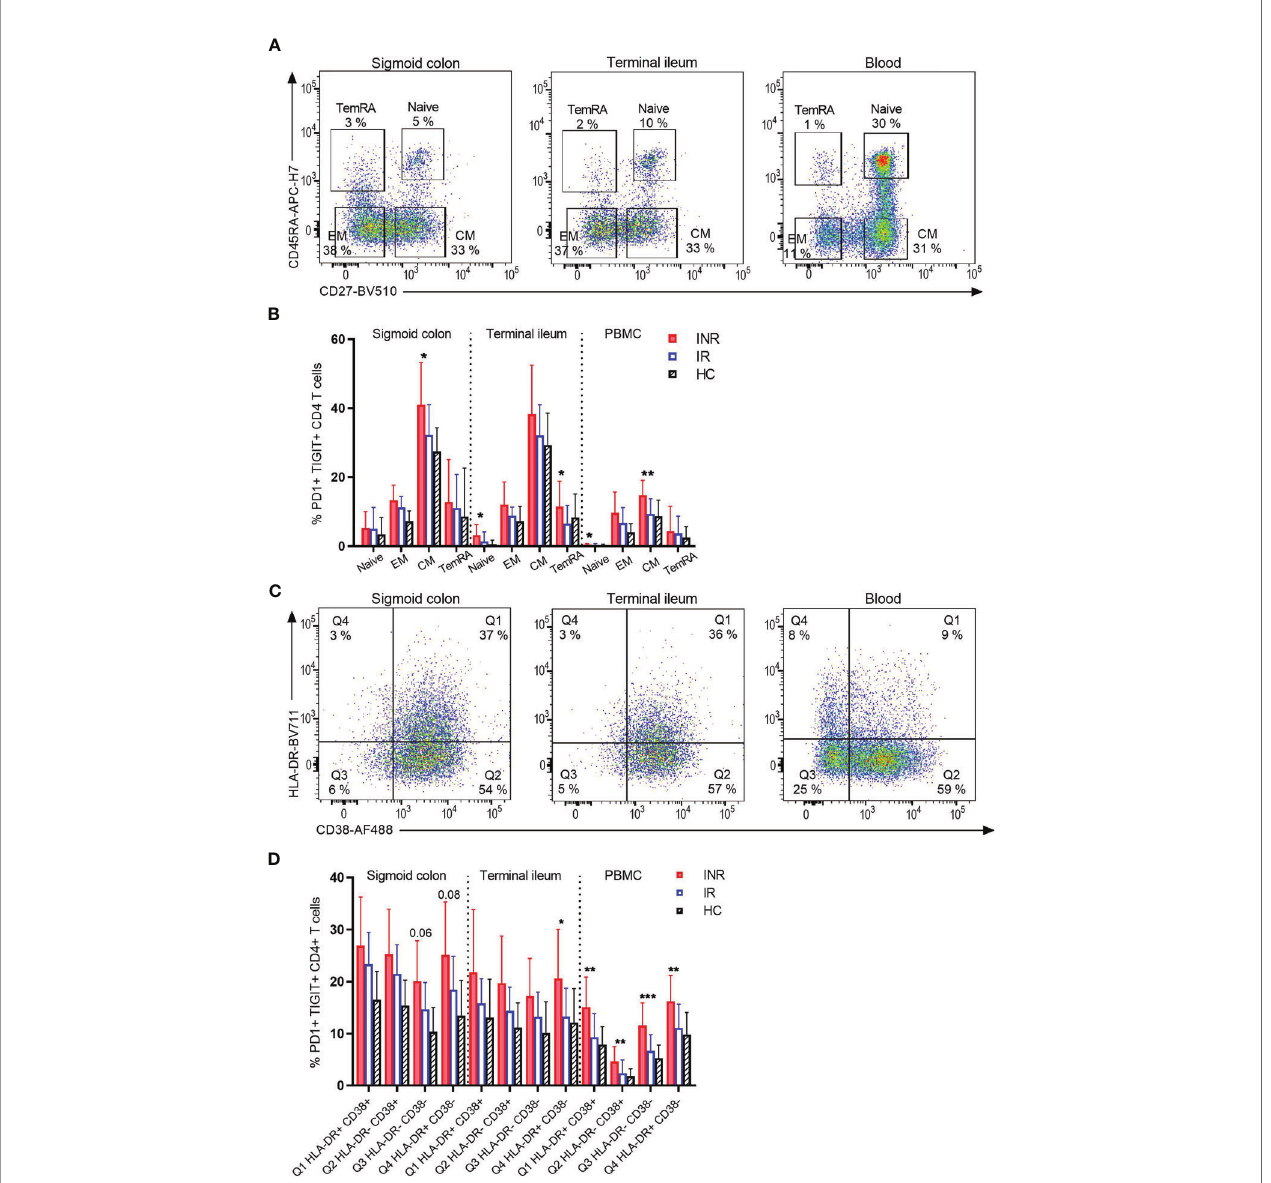
FIGURE 3 | INR display more exhaustion of various CD4 + T cell subpopulations, both in gut and blood. (A) Representative fl ow cytometry plot of differentiated CD4 + T-cell subpopulations based on CD45RA and CD27 expression (naive: CD45RA + CD27 + , EM: CD45RA - CD27 - , CM: CD45RA - CD27 + , TemRA: CD45RA + CD27 - ) in the three segments sigmoid colon, terminal ileum and blood of an INR. (B) Comparison of PD1 + TIGIT + cells within each CD4 + T cell subpopulation in the three segments. (C) Representative fl ow cytometry plot of HLA-DR and CD38 expression in the three segments sigmoid colon, terminal ileum and blood of an INR. (D) Comparison of PD1 + TIGIT + cells within each CD4 + T cell subpopulation of HLA-DR and CD38 expression in the three segments. INR (red), IR (open blue) and HIV negatives (black lined). Error bars indicate standard deviation. Statistical analyses were performed by Kruskal-Wallis (KW) test with Dunn ’ s post-test between INR and IR. * P < 0.05, ** P < 0.01, *** P <